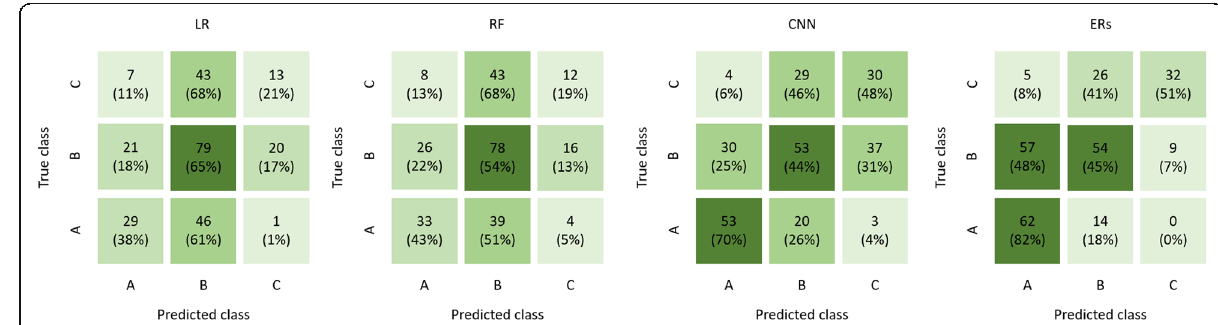
Fig. 3 Confusion matrix for the prediction of the Child-Pugh class. From left to right: linear regression (LR), random forest (RF), convolution neural network (CNN), and experienced radiologists (ERs). Values in brackets are relative to the numbers of patient in the ground truth Child-Pugh